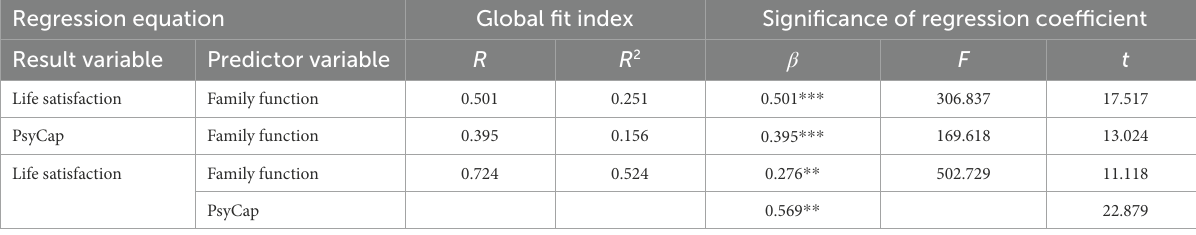
TABLE 4 Regression analysis of family function, life satisfaction, PsyCap, and cognitive-emotion regulation.